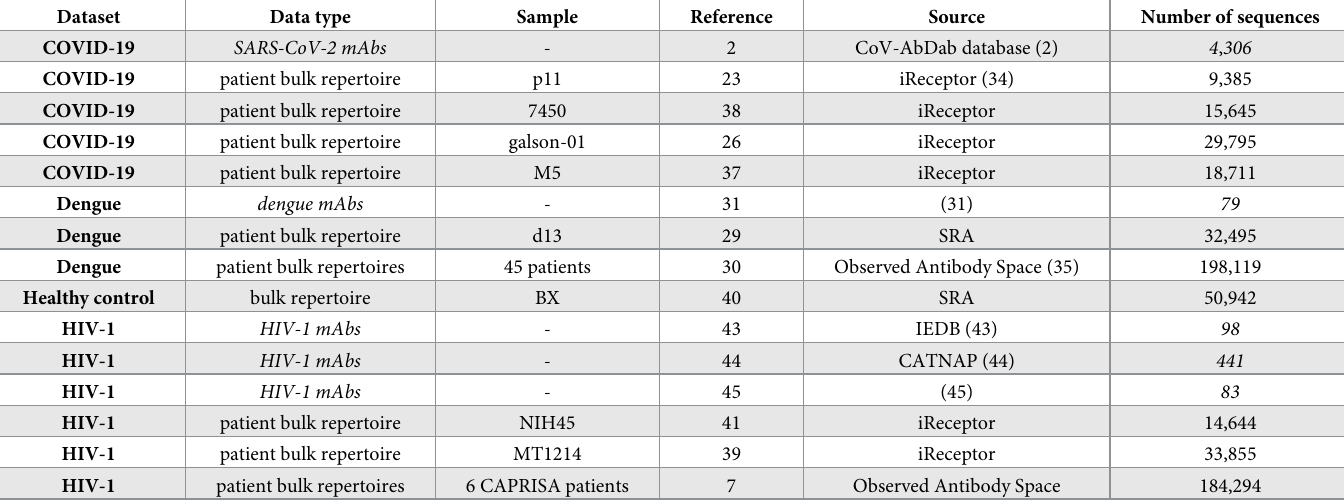
Table 2. Datasets used in AIRRscape. Datasets in italics are collections of antibodies.